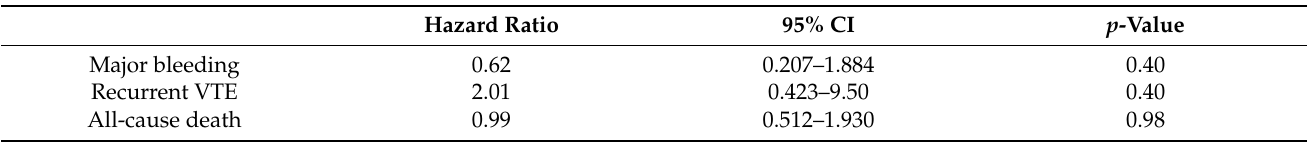
Table 7. Validation of prolonged therapy for major bleeding, recurrent VTE, and all-cause death after propensity matching with IPTW